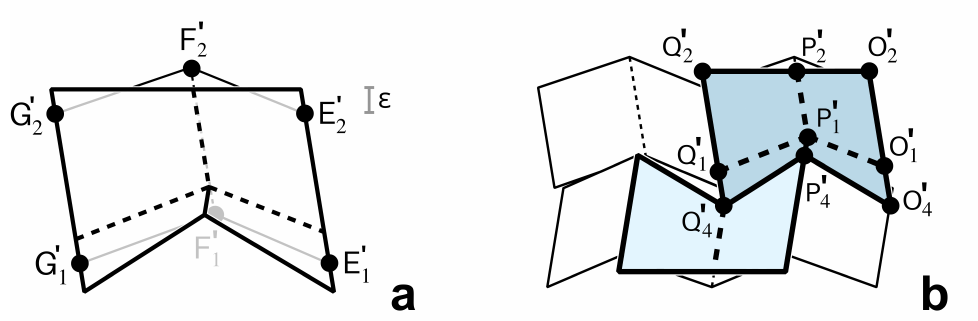
Figure 7. ( a ) Placing S 4 on C 4 . ( b ) Attaching S 4 to asymmetric zipper-coupled tubes.